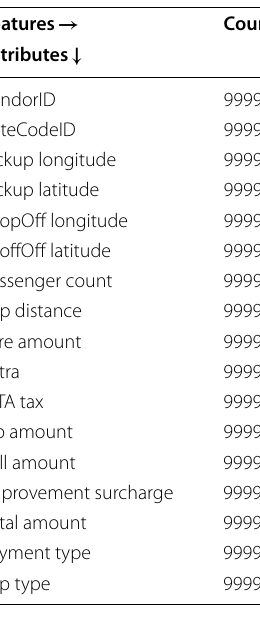
Table 4 Statistical features of the dataset a